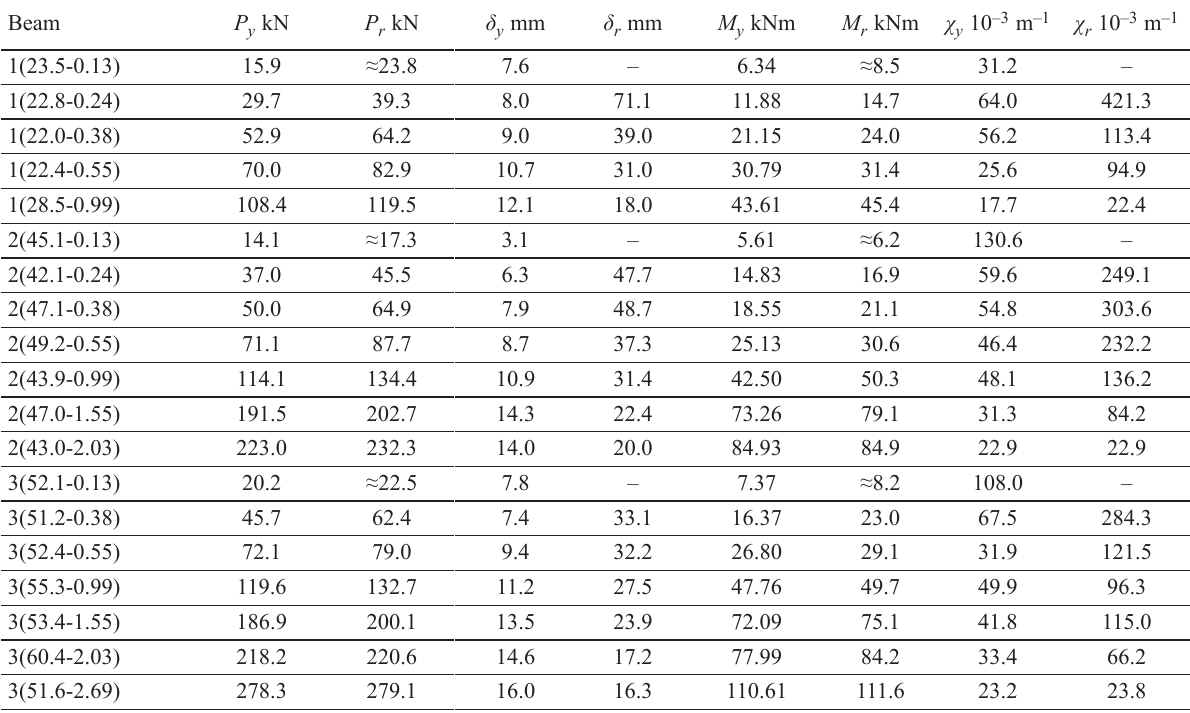
Table 4. Key points of P – δ and M – χ curves